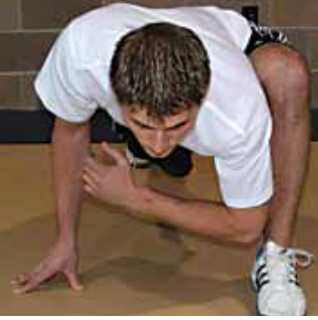
Figure 5-9a. Forward Lunge Figure 5-9c. Bring Elbow Toward InstepFigure 5-9b. Bring Torso Toward Front Knee